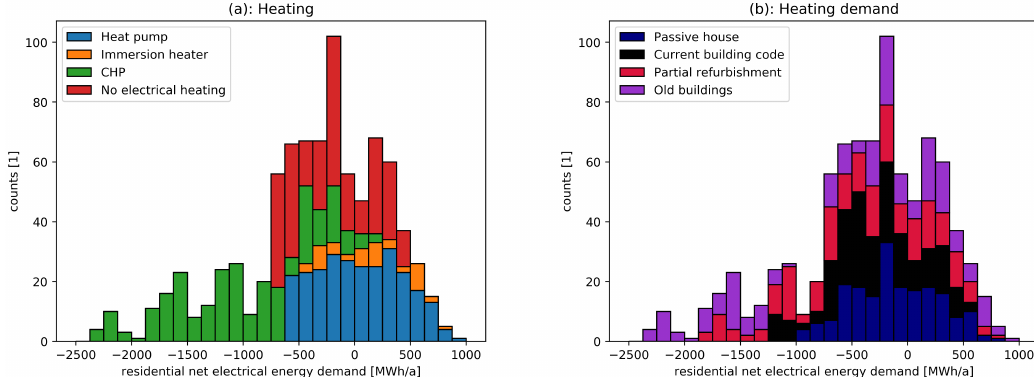
Figure 9. Heating sector related factors within the scenario space: ( a ) heating technology; and ( b ) heat demand due to space heating.